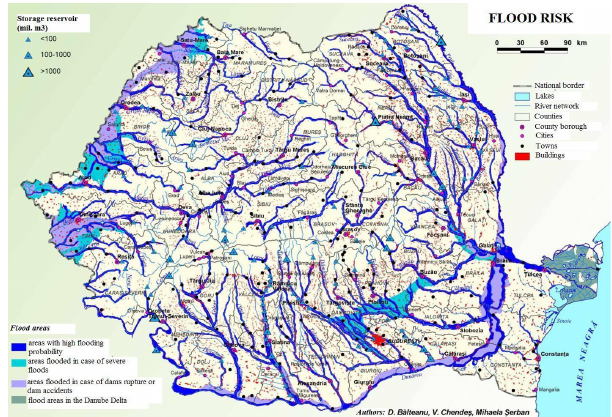
Fig. 4. Seismic zoning of Romania. Figure 4. Seismic zoning of Romania 3